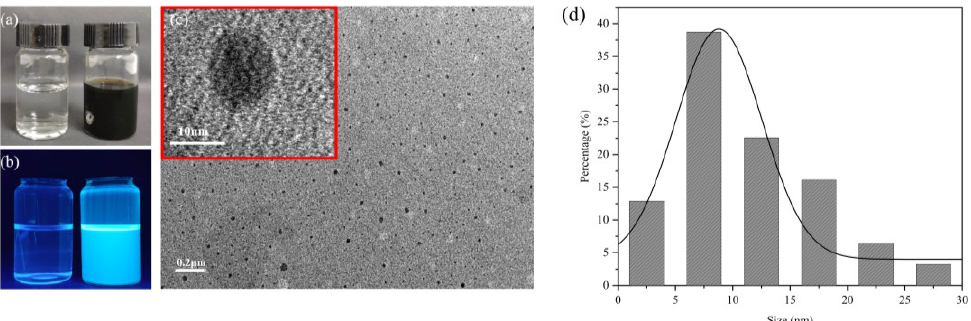
Figure 1. ( a ) Appearance of CDs under sunlight. Control with deionized water on the left and CDs solution on the right. Same below. ( b ) Appearance of CDs under 365 nm UV lamp. ( c ) TEM image of CDs with the 0.2 μ m and the 10nm scale (red box). ( d ) Statistical diagram of CDs particle size distribution. The black line is the Gaussian fitting curve. The average particle size was 8.45 nm.